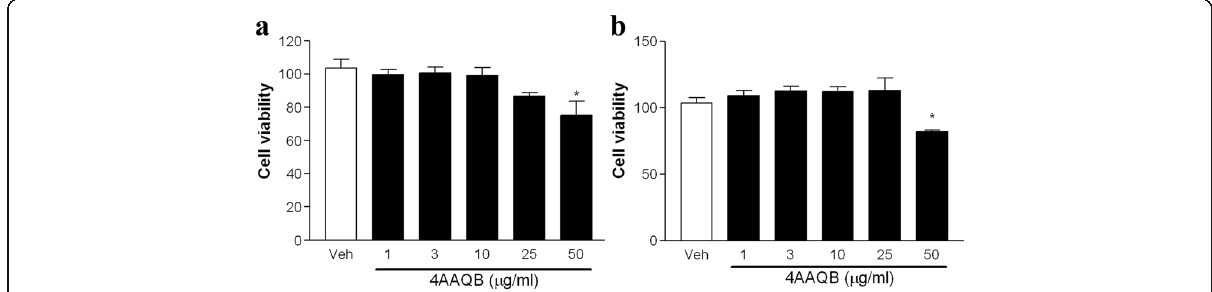
Fig. 1 Effect of 4AAQB on cell viability of murine macrophages stimulated with lipopolysaccharides (LPS). RAW264.7 macrophages ( a ) or peritoneal macrophages ( b ) were incubated with various concentrations of 4AAQB in the presence of LPS (100 ng/ml) for 24 h. Cell viability was determined by MTT assay. Data are expressed as the mean±S.E.M of three independent experiments and * p <0.05 as compared with DMSO vehicle